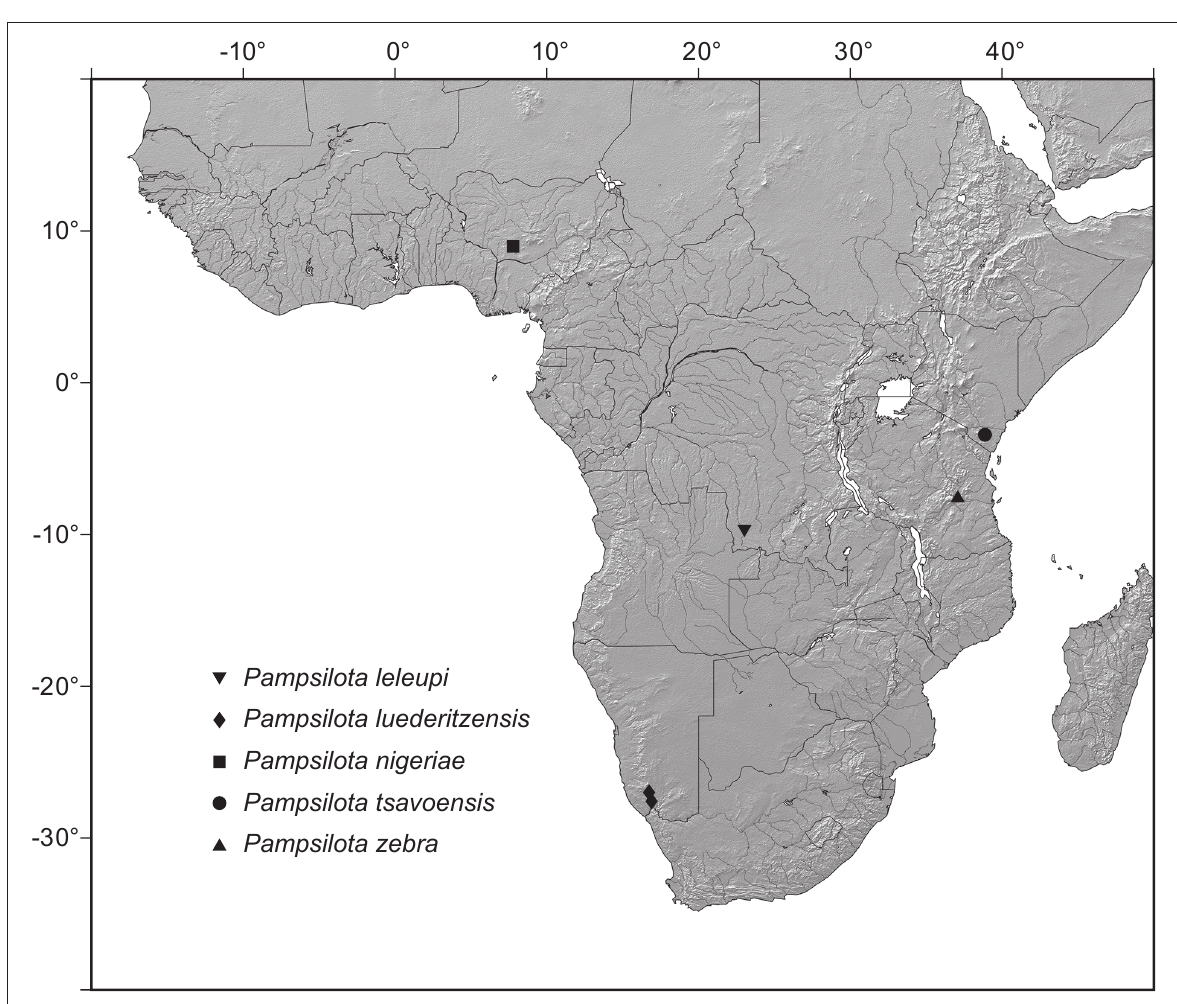
Figure 37. Distribution map for Pampsilota leleupi , P. luederitzensis , P. nigeriae , P. tsavoensis , and P. zebra